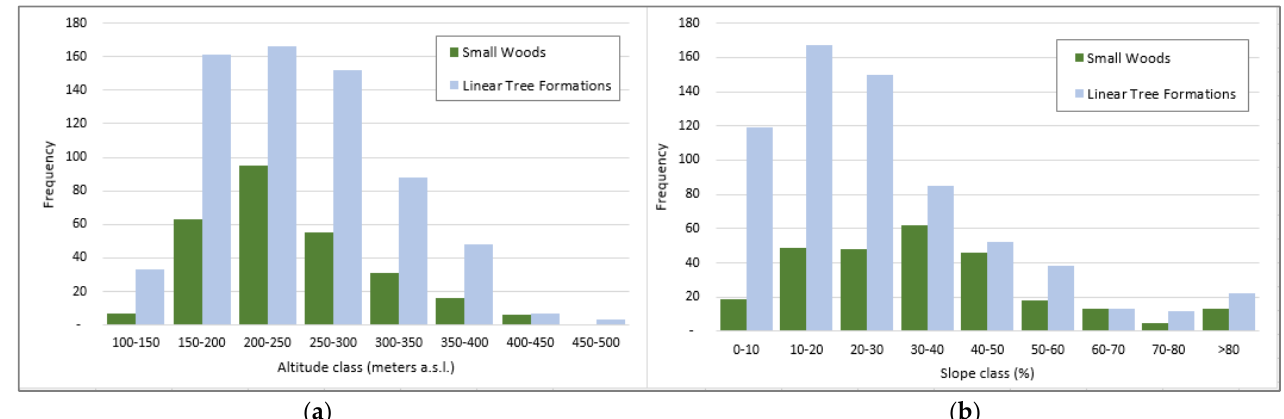
Figure 4 . Graphs of the distribution of the two typologies of TOF NON A/U according to altimetry ( a ) and to slope class ( b ) in the Colline del Prosecco UNESCO site Core Area in 2021. Table 4. Variation of the average surface of TOF NON A/U according to the different altitudinal classes.